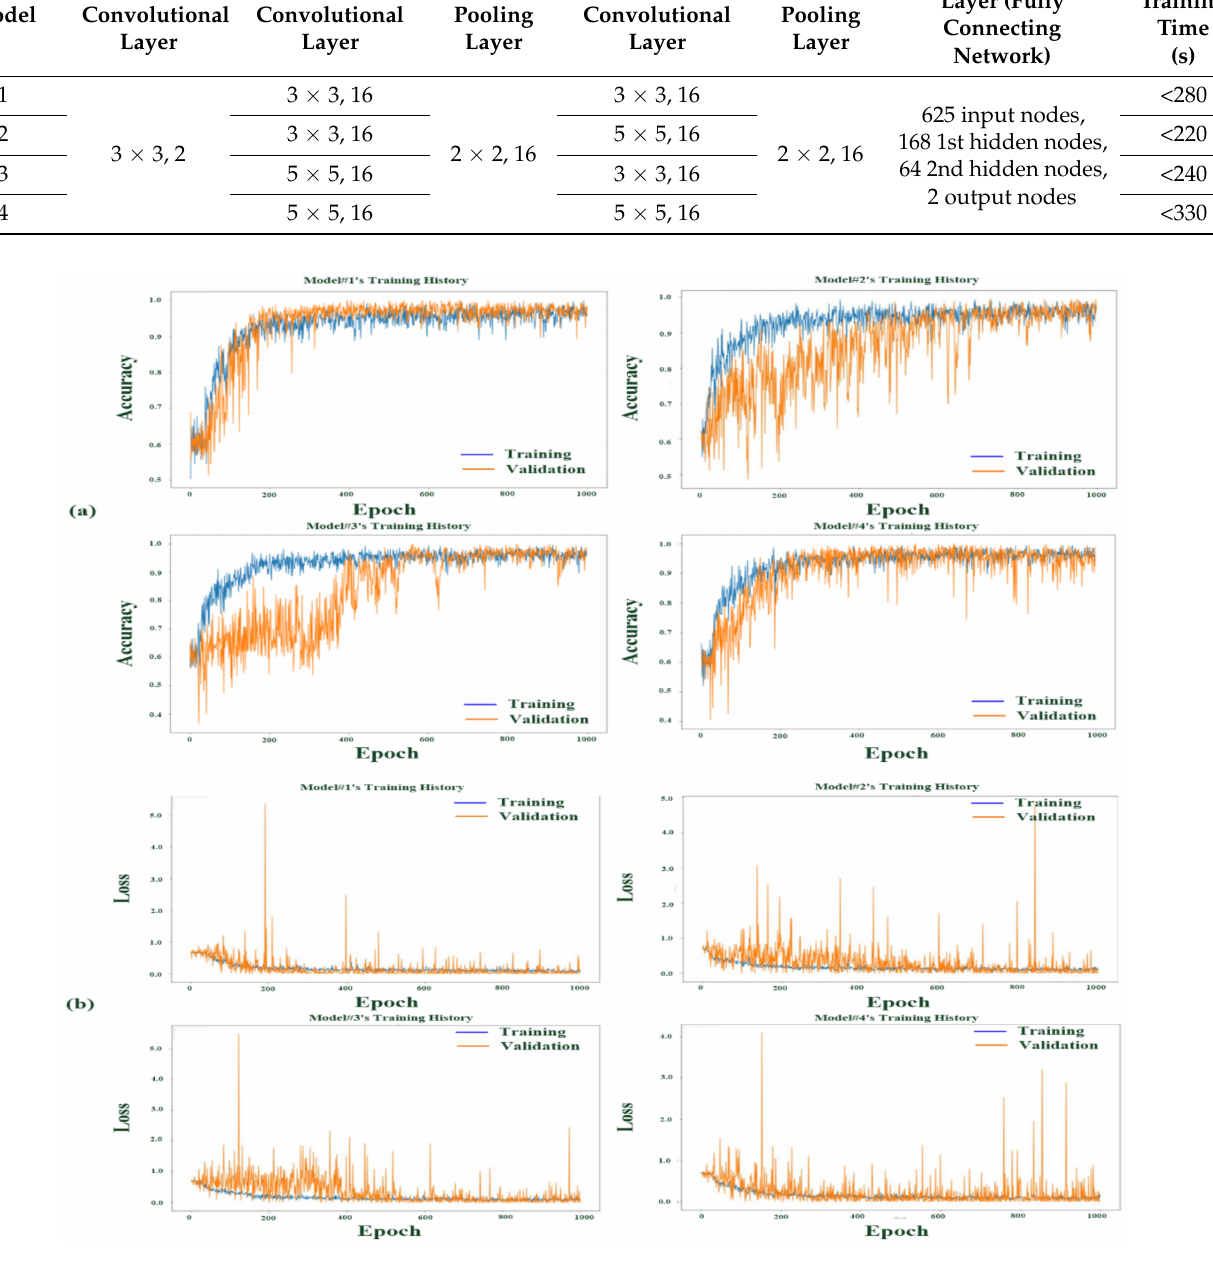
Figure 7. Training history curves of the multilayer CNN-based classifier. ( a ) Training performance test and classification performance validation as seen classification accuracy versus the training epoch and ( b ) classifier training convergence curve as a loss function versus the training